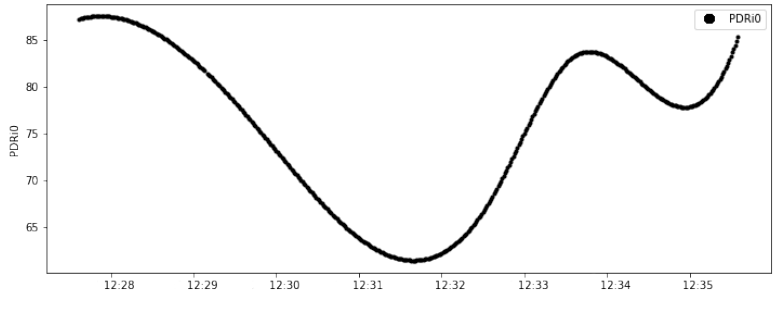
Figure 12. Test 02: Link0